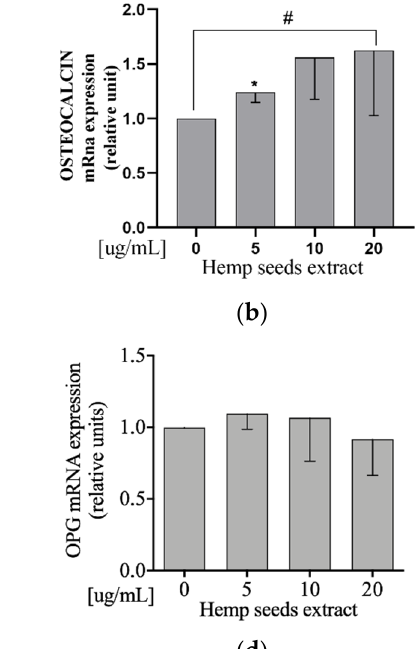
Figure 3. HSE increases activity and protein levels of Alkaline Phosphatase on Saos-2 cells. Semi-confluent cultures of human osteoblast-like cells (Saos-2) were incubated with HSE 5, 10, or 20 µg/mL for 24 hours. ( a ) ALP activity was measured by pNPP method. ( b ) Cell proteins were analyzed by Western blotting with antibodies specific to alkaline phosphatase and β -actin. Data are represented as mean ± SD. Statistical analysis: Linear regression # p < 0.05.